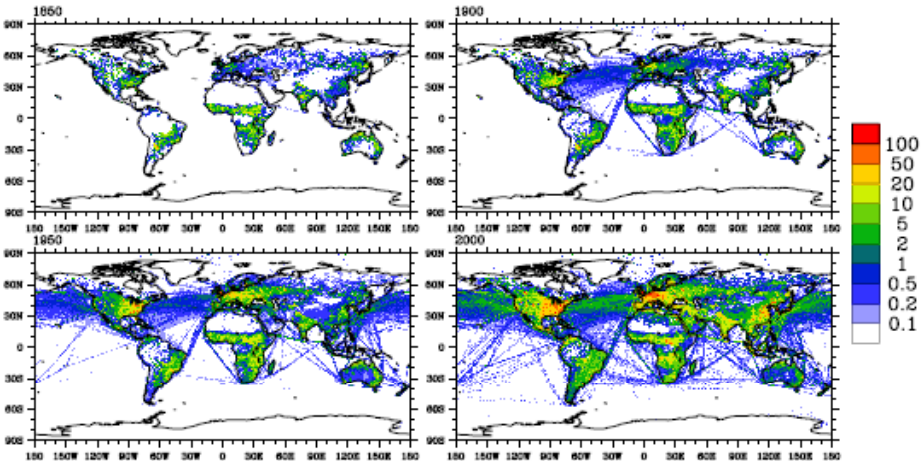
Fig. 4. Total annual emissions (anthropogenic, shipping and biomass burning) of NO x (Tg(N)/year) for 1850 (top left), 1900 (top right), 1950 (bottom left) and 2000 (bottom